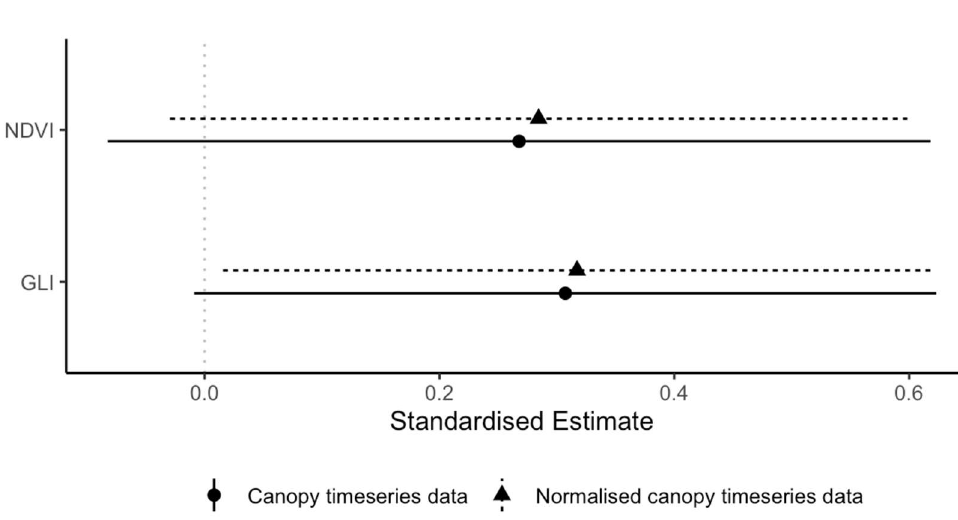
Figure 6. Detecting new leaves using satellite data. Standardized estimates (dots) and 95% confidence intervals (lines) from two separate generalized linear mixed models (binomial) of the probability of detecting new leaves using the Sentinel-2 data. The normalized difference vegetation index (NDVI) and the green leaf index (GLI) are derived indices from optical data from Sentinel-2. Mixed models included tree ID and year as random effects.